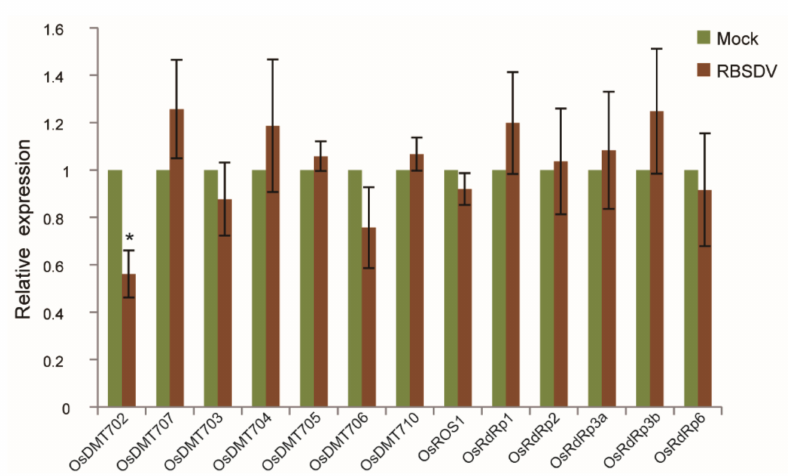
Figure 5. Expression levels of genes involved in DNA methylation / demethylation in rice infected by RBSDV. Each biological sample with 8 to 12 RBSDV-infected rice seedlings at 30 dpi were used for RT-qPCR. Vertical bars represent standard deviation (SD) of the mean of five biological replicates. dpi: days post inoculation. Mock: RBSDV-free seedling. Significant di ff erences were identified using two-tailed Student’s t -test. * At the top of columns indicates significant di ff erence at p ≤